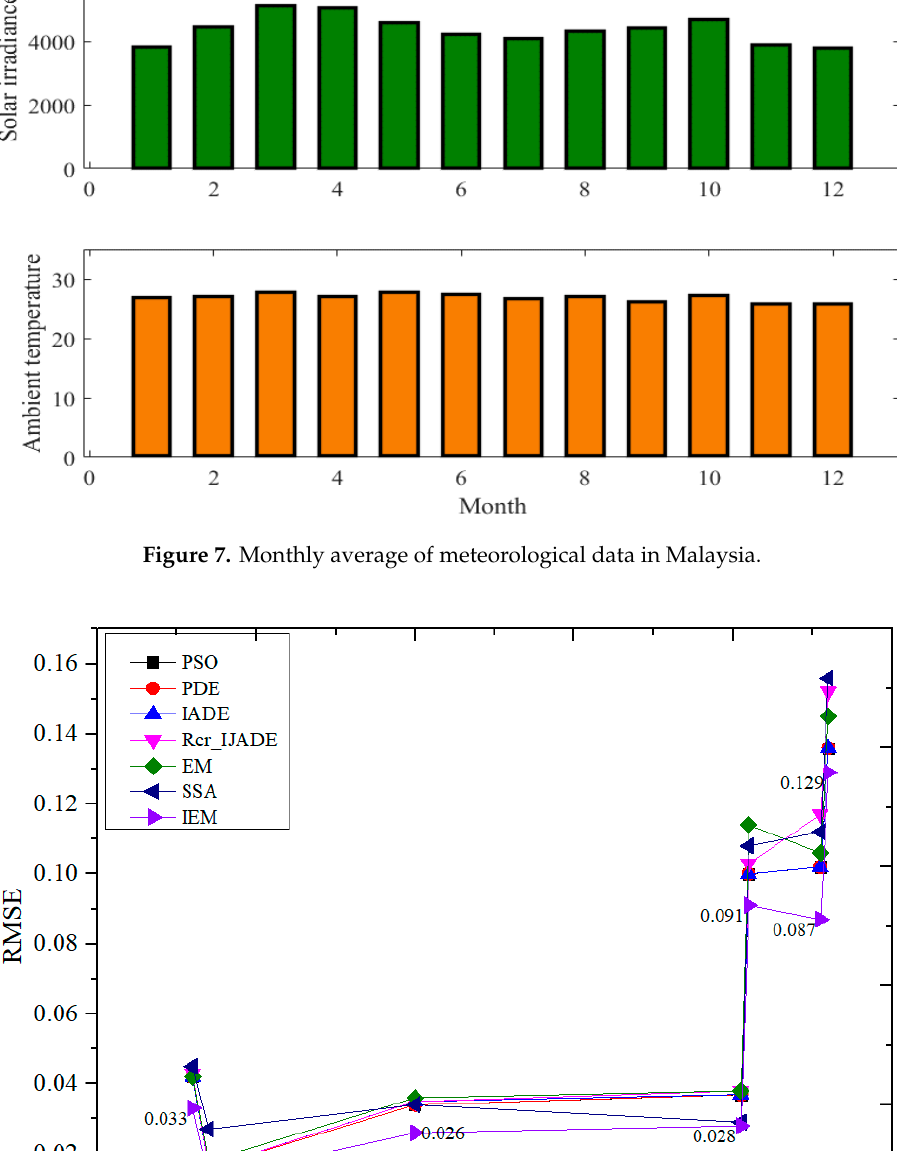
Figure 7. Monthly average of meteorological data in Malaysia.